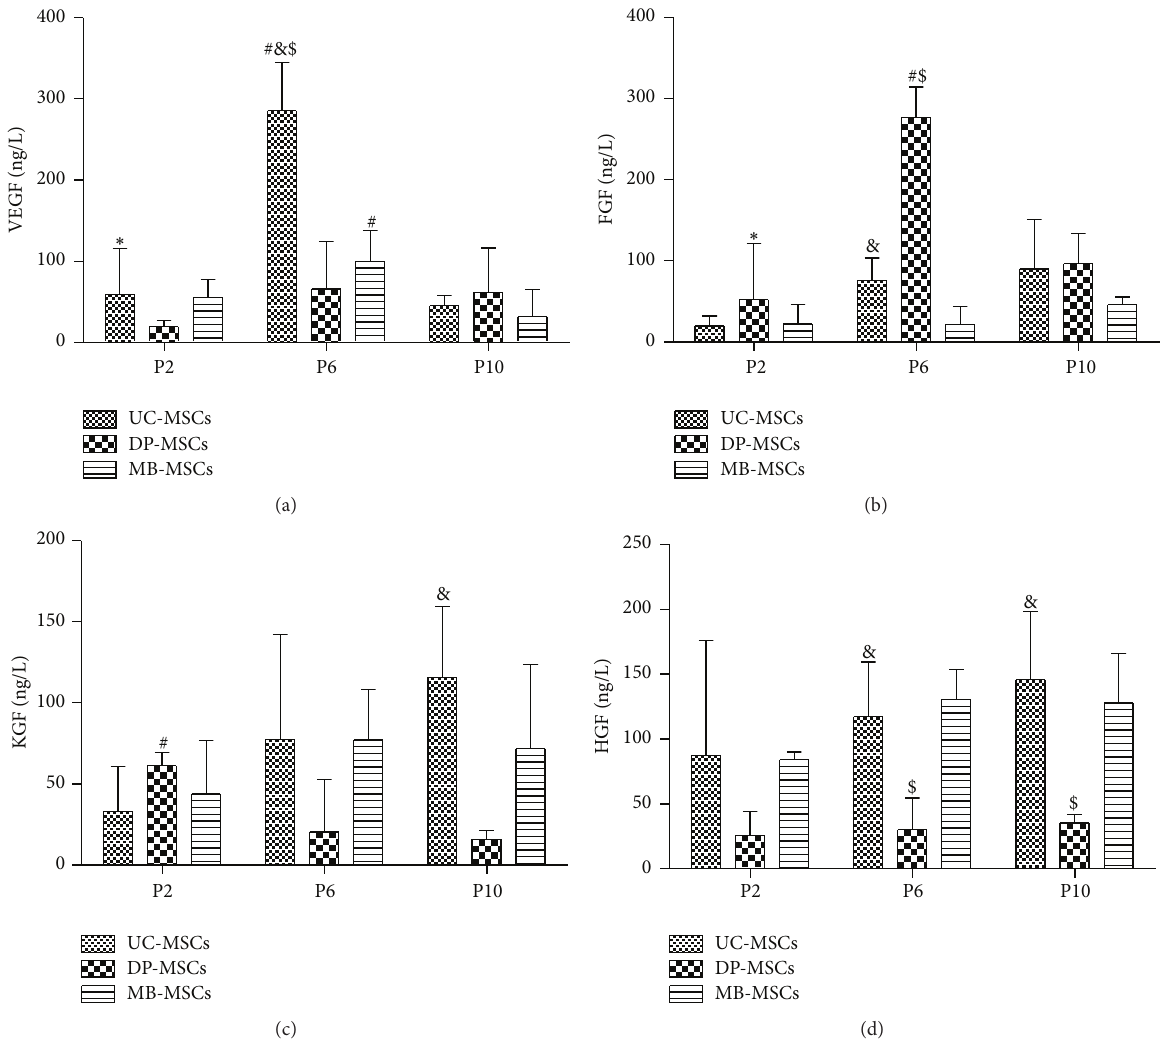
Figure 7: Cytokines of UC-, DP-, and MB-MSCs. (a) VEGF expression; (b) FGF expression; (c) KGF expression; (d) HGF expression. Each experiment was performed in triplicate: ∗ compared with DP-MSCs at corresponding passage; # compared with MB-MSCs at corresponding passage; & compared with P6 of corresponding MSCs; $ compared with P10 of corresponding MSCs, 𝑝 < 0.05 . UC-MSCs: umbilical cord mesenchymal stem cells; DP-MSCs: dental pulp mesenchymal stem cells; MB-MSCs: menstrual blood mesenchymal stem cells; P: passage; VEGF: vascular endothelial growth factor; FGF: fibroblast growth factor; KGF: keratinocyte growth factor; HGF: hepatocyte growth